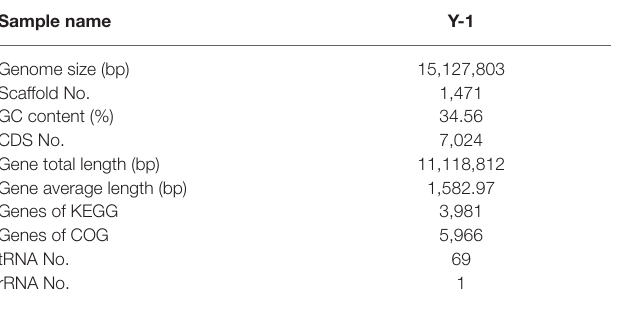
TABLE 1 | Genome features of strain Wickerhamomyces anomalus